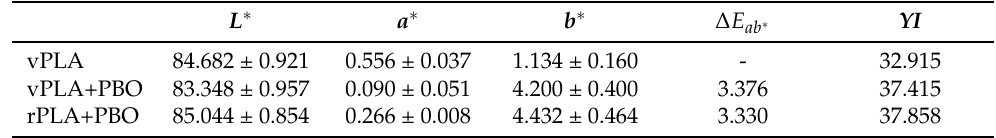
Table 3. Average numbers for luminance ( L ∗ ), green-red ( a ∗ ), blue-yellow ( b ∗ ), total color difference ( ∆ E ab ∗ and yellowness index (YI) for virgin PLA (vPLA), virgin PLA mixed in the presence of PBO (vPLA+PBO), and recycled PLA mixed in the presence of PBO